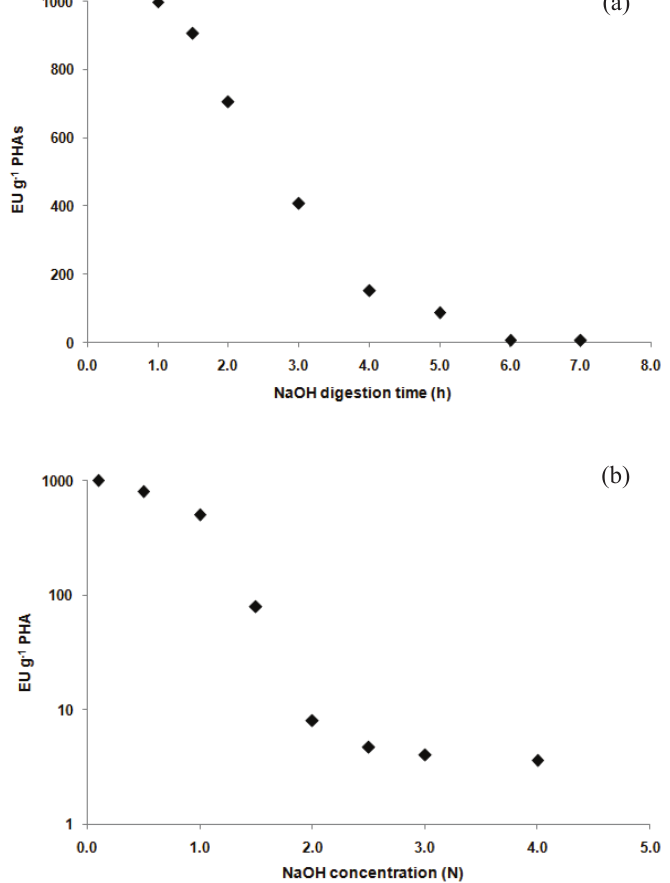
Fig. 6 – a) Effect of NaOH digestion time (h) on endotoxin level (EU g –1 ) present in extracted PHAs; b) Effect of different NaOH concentration (N) on endotoxin levels present in